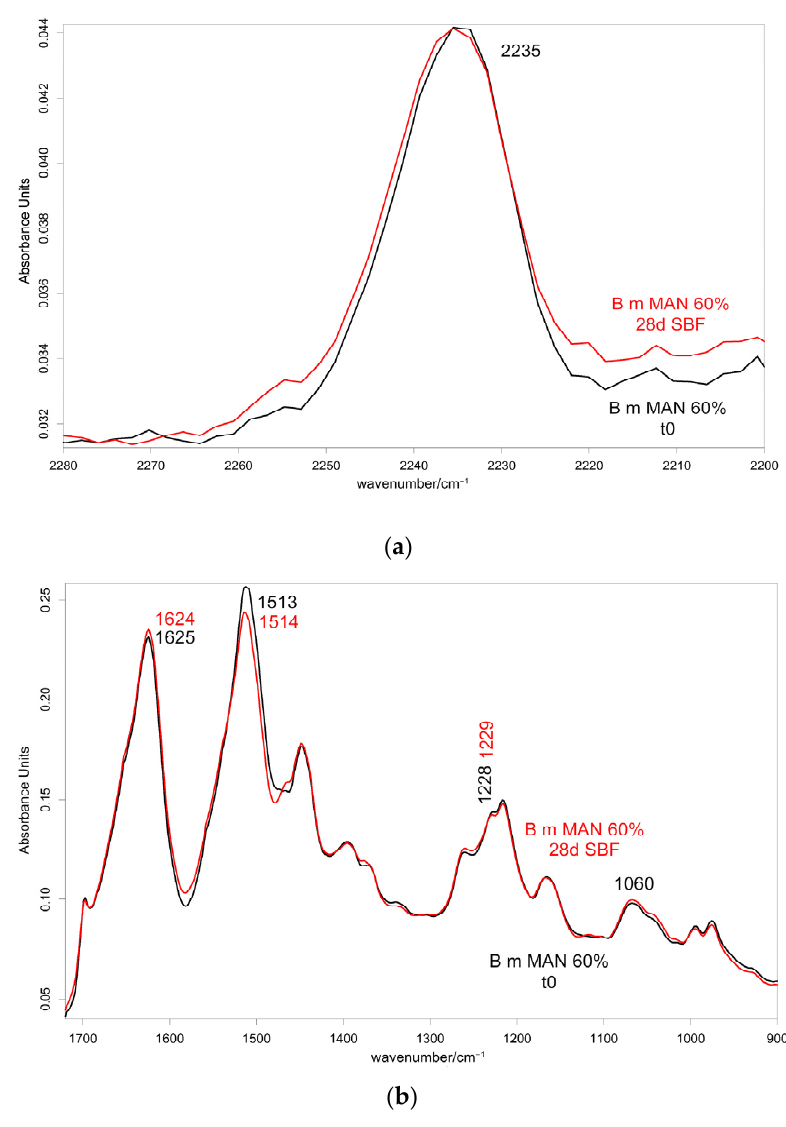
Figure 15. IR spectra recorded in the perpendicular orientation on the 60% MAN-grafted fibers be- fore and after ageing for 28 days in SBF in the 2280–2200 cm − 1 ( a ) and 1720–900 cm − 1 ( b ) spectral ranges.